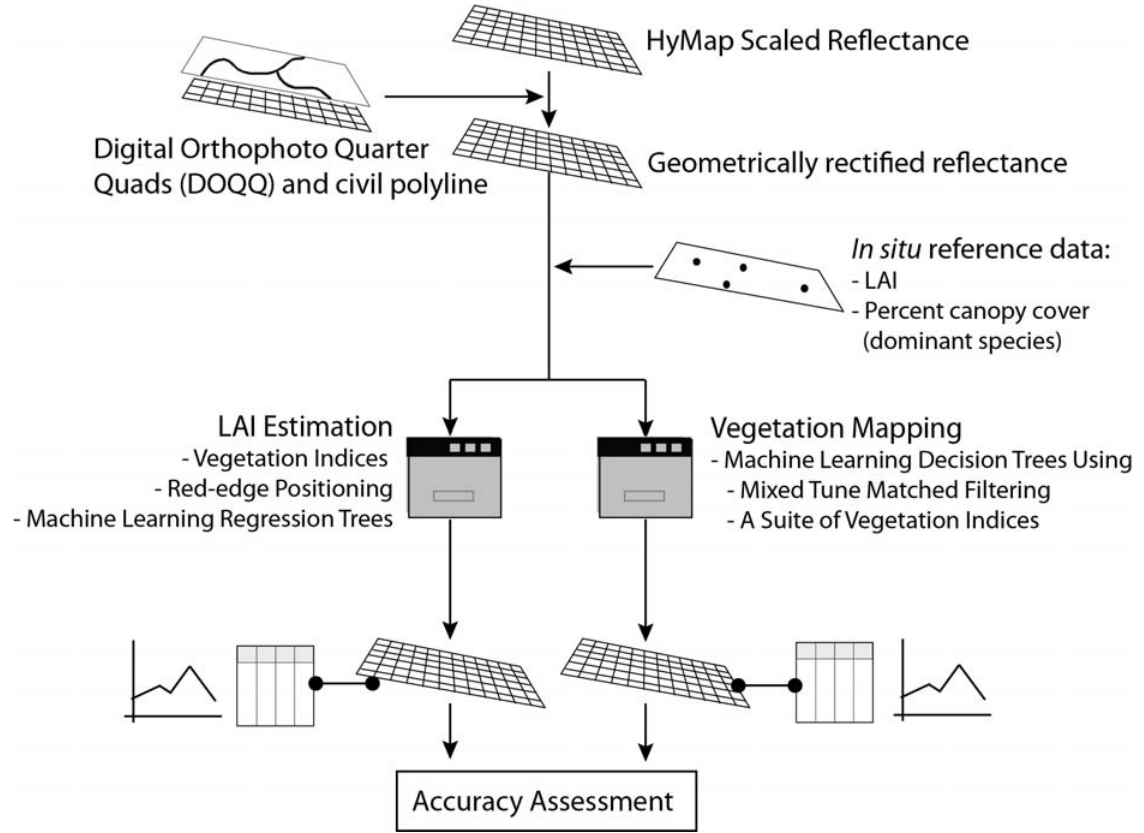
Figure 2. Digital image processing flow